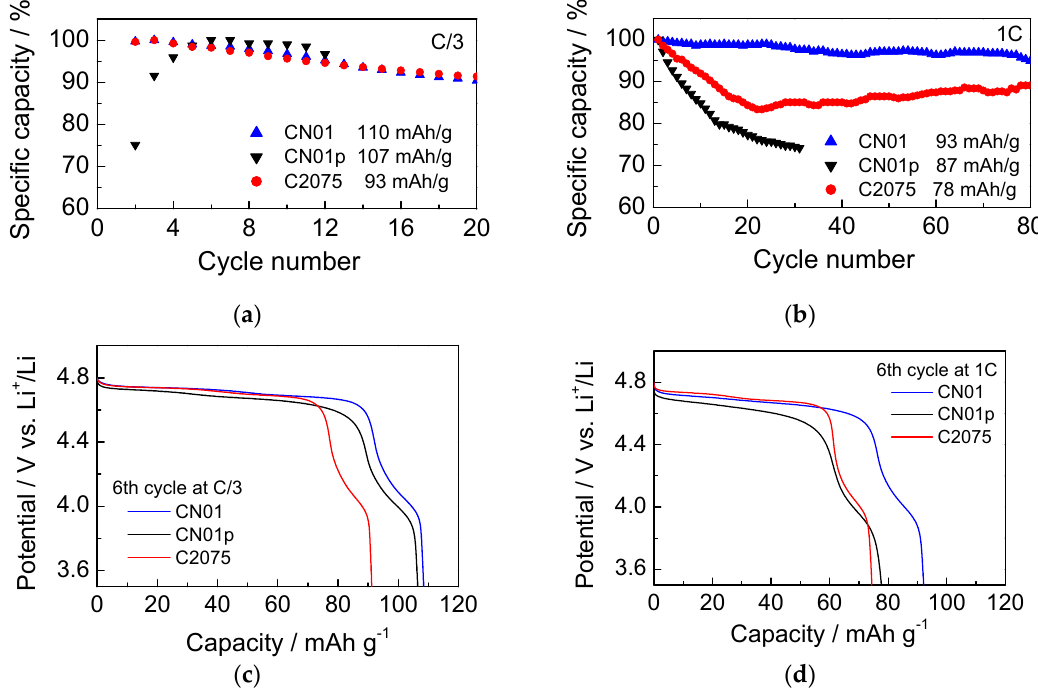
Figure 7. Percentage of discharge specific capacity at ( a ) C/3 and ( b ) 1C; ( c ) discharge curves at C/3 (6th cycle) of CN01, C2075, and CN01p cells; ( d ) discharge curves at 1C (6th cycle) of CN01, C2075, and CN01p cells.